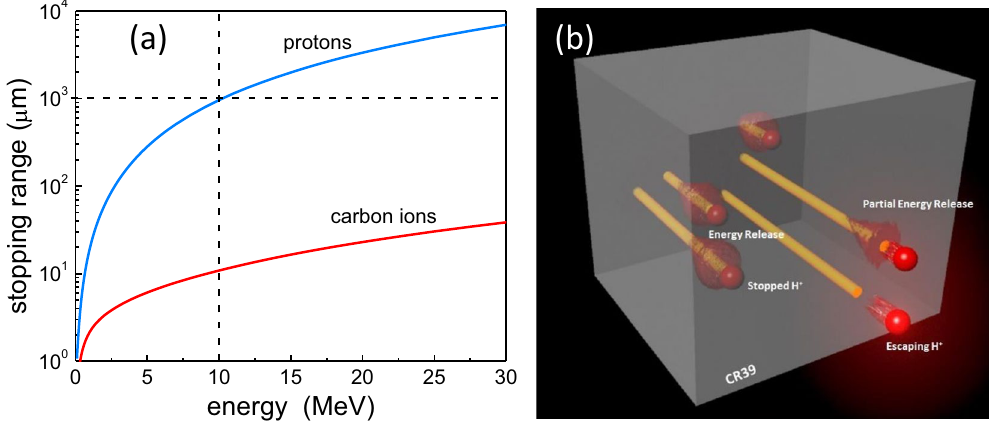
Figure 2. Particle stopping processes in the medium. ( a ).The stopping ranges of carbon ions and proton in CR-39 as a function of energy calculated by SRIM. The horizontal dotted line indicates that the stopping range of 10 MeV protons is equivalent to the 1 mm thickness of CR-39. ( b ) An artistic rendition depicts stopping process of protons with various energies in the CR-39